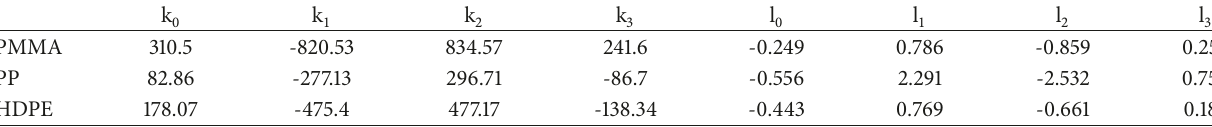
Table 2: Different material parameters in the size-based viscous flow activation energy (SVAE) model.